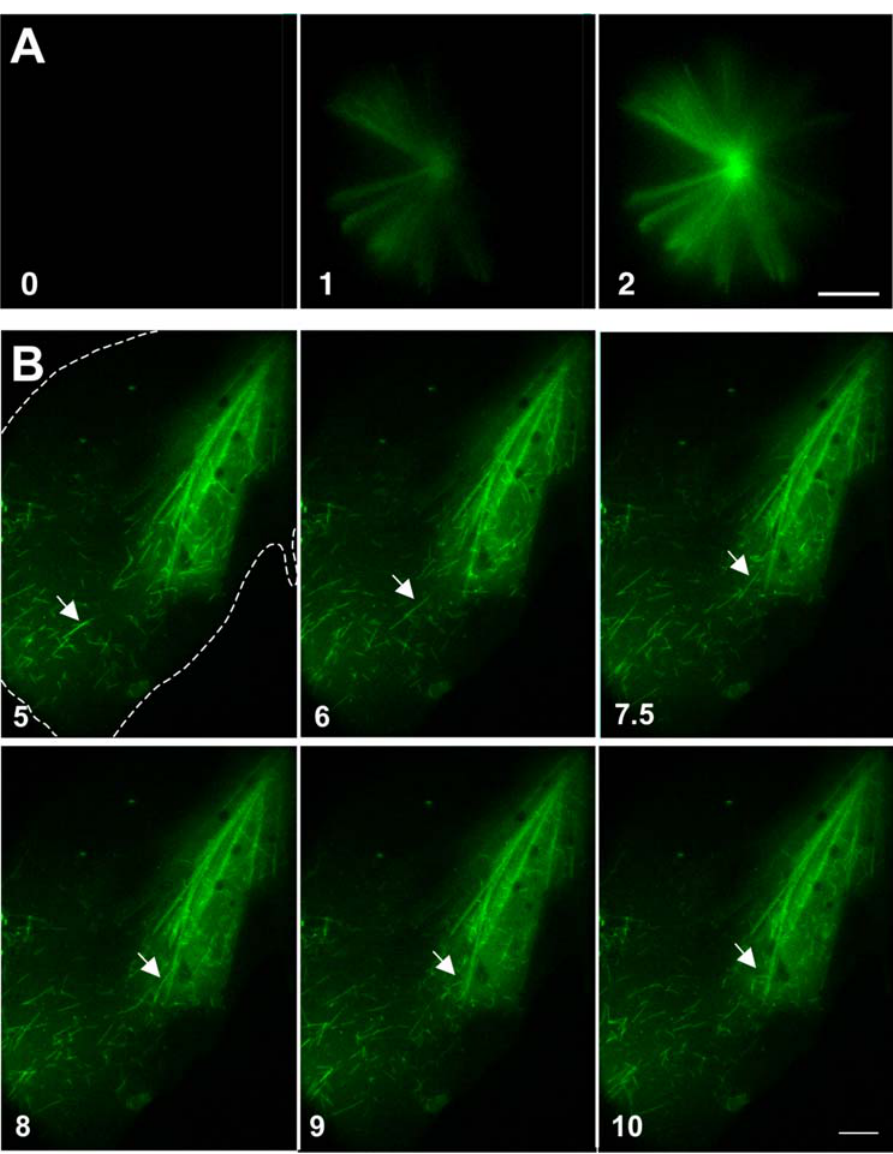
Figure 2. Taxol crystals bind fluorescently labeled tubulin subunits. (A) Fluorescently labeled tubulin (released from a micropipette to the left of the field) immediately accumulated on the preformed Taxol crystal aster, as shown in these sequential images. (B) An equilibrium solution of fluorescently labeled tubulin (green haze) and microtubules was released as in (A), and decorated a Taxol ‘bow-tie’ (i.e., nonspherical) crystal aster (half of aster is visible, in upper right). Again, the crystal was instantly labeled by subunits, which diffuse more rapidly than microtubules. Microtubules did not appear to contribute to the brightness of the tubulin-decorated crystal, as fluorescence intensity did not increase over time. Thus, microtubules did not appear to play a major role in decorating the Taxol crystal. The arrow tracks the path of a single microtubule that briefly made contact with the aster, but diffused away. The shallow aqueous puddle containing the crystal aster is outlined in the first panel. Time in seconds. Bars, 10 m